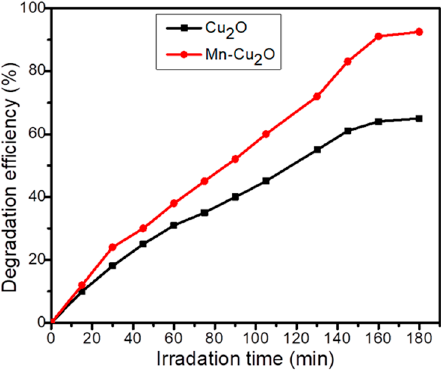
Figure 7. Photocatalytic degradation of amoxicillin using Cu 2 O and Mn-Cu 2 O under the optimal conditions (pH = 9, C0 = 15 mg/L and amount of catalysts = 1 g/L).